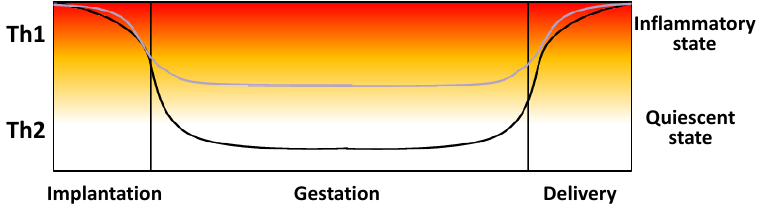
Figure 3. Schematic representation of the cytokine profile from implantation to parturition. The line in black represents a normal pregnancy, while the line in grey represents one complicated with preeclampsia. During implantation, high amounts of pro-inflammatory cytokines such as IL-6, IL-15, and TNF- α are needed so that trophoblasts can invade the maternal vascular and endometrial tissue, which results in the recruiting and activation of immune cells. Then, pregnancy continues with a peaceful immune profile, allowing the fetus to grow. Finally, for parturition to occur, reactivation of inflammation must take place. In preeclampsia, an overall pro-inflammatory systemic environment with increased Th1 cytokines has been observed in maternal serum, amniotic fluid, and umbilical serum.